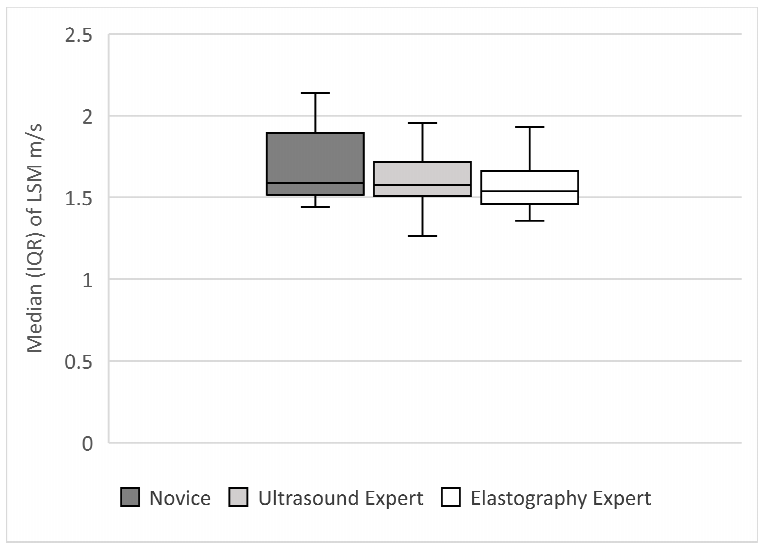
Figure 5. Elastographic measurements obtained by the three categories of examiners: novice, elastography expert and ultrasound expert. Boxplots depict 25–75% interquartile range (box), median (middle line), 5–95% range (two outer lines).